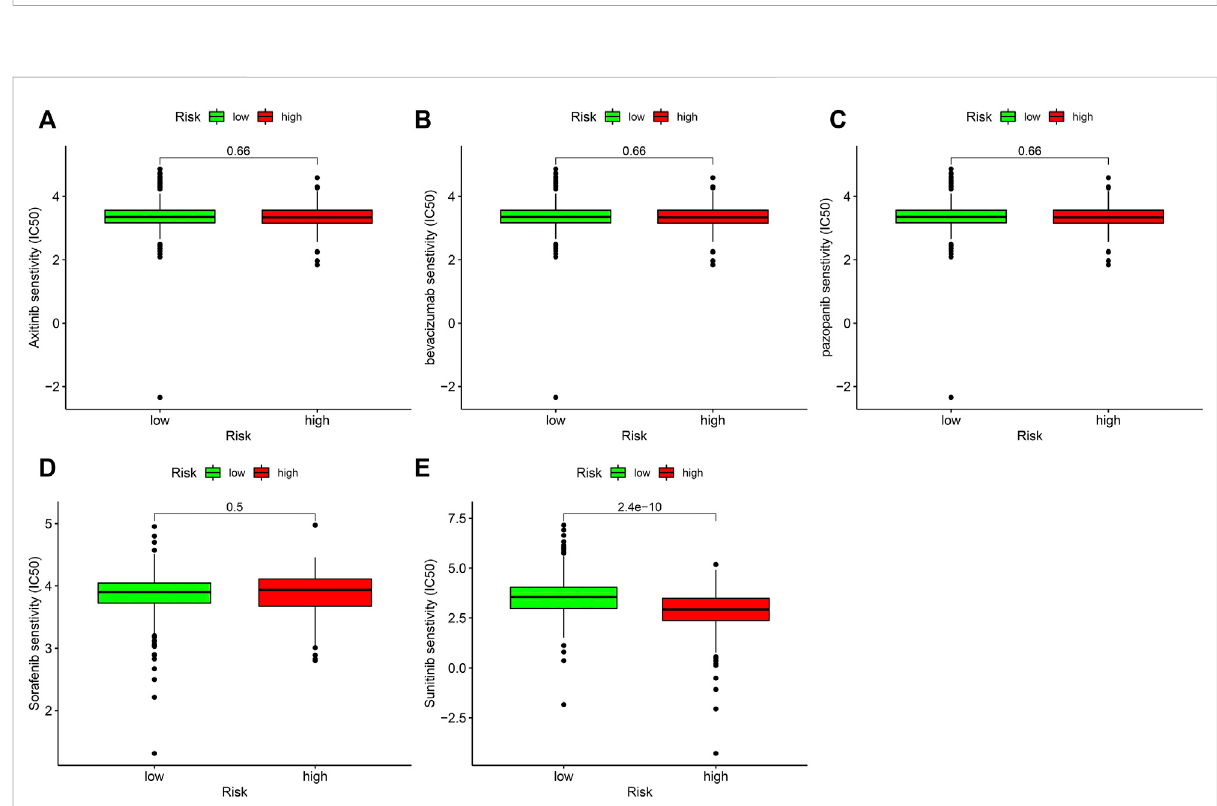
FIGURE 8 Associationsbetweenriskmodelandthesusceptibilitytochemomedicines.ComparisonoftheIC50resultsof (A) axitinib. (B)